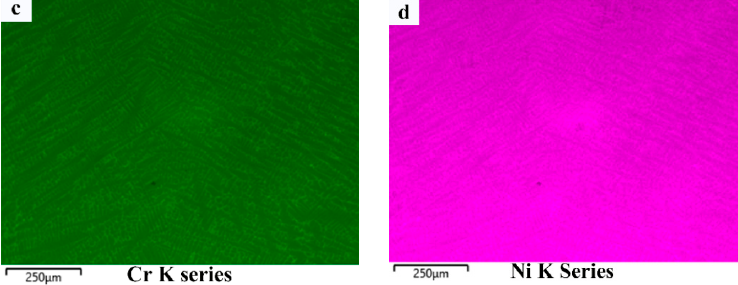
Figure 4. Macrograph and Element distribution map of weld; ( a ) Macrograph of the weld metal; and ( b – d ) Element distribution of Fe, Cr, and Ni in weld metal respectively . Table 3. Chemical composition of weld metal (wt.%).